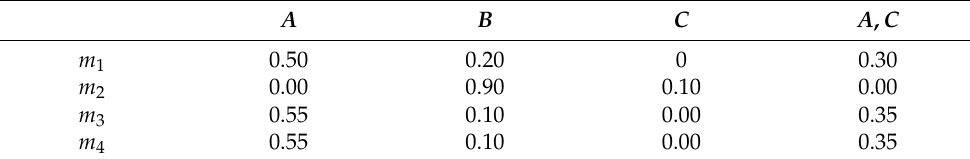
Table 5. BPAs in Application